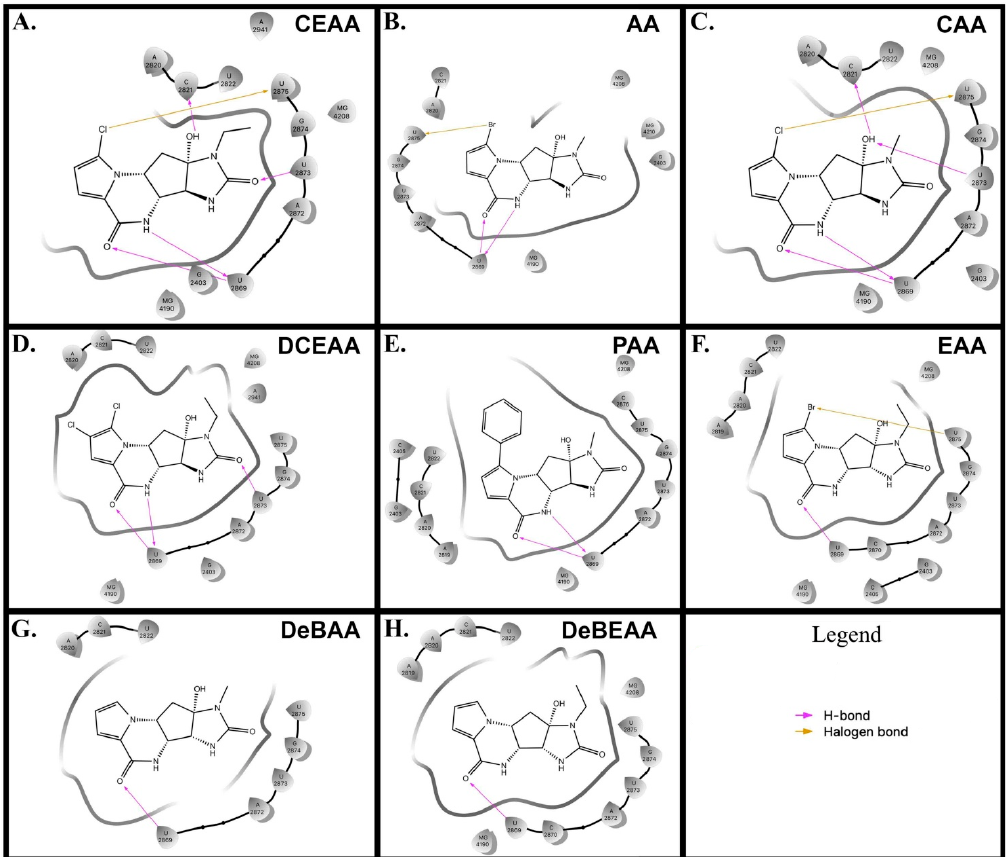
Figure 3. Two-dimensional ligand interaction diagram for peptidyl transferase center (PTC) of the ribosome with AA analogs. Comprehensive list for all 2D Ligand Interaction Maps for CEAA, AA, CAA, DCEAA, PAA, EAA, DeBAA, and DeBEAA with the ribosome PTC is given. Arrows indicate key interactions or other colormetric cues as indicated in the legend on bottom right. (A) CEAA is shown with extra binding features that may enhance its activity. (B) AA is shown bound to the PTC with the indicated interactions. (C) CAA is given for its PTC binding. (D) DCEAA has some interesting repositioning due to its extra chloro- moiety. (E) PAA has a frustrated orientation due to the large phenyl moiety. (F) EAA reveals loss of interactions. (G) DeBAA has a very weak hold in pocket with only minor contact. (H) Similarly, DeBEAA is weakened in the binding pocket.